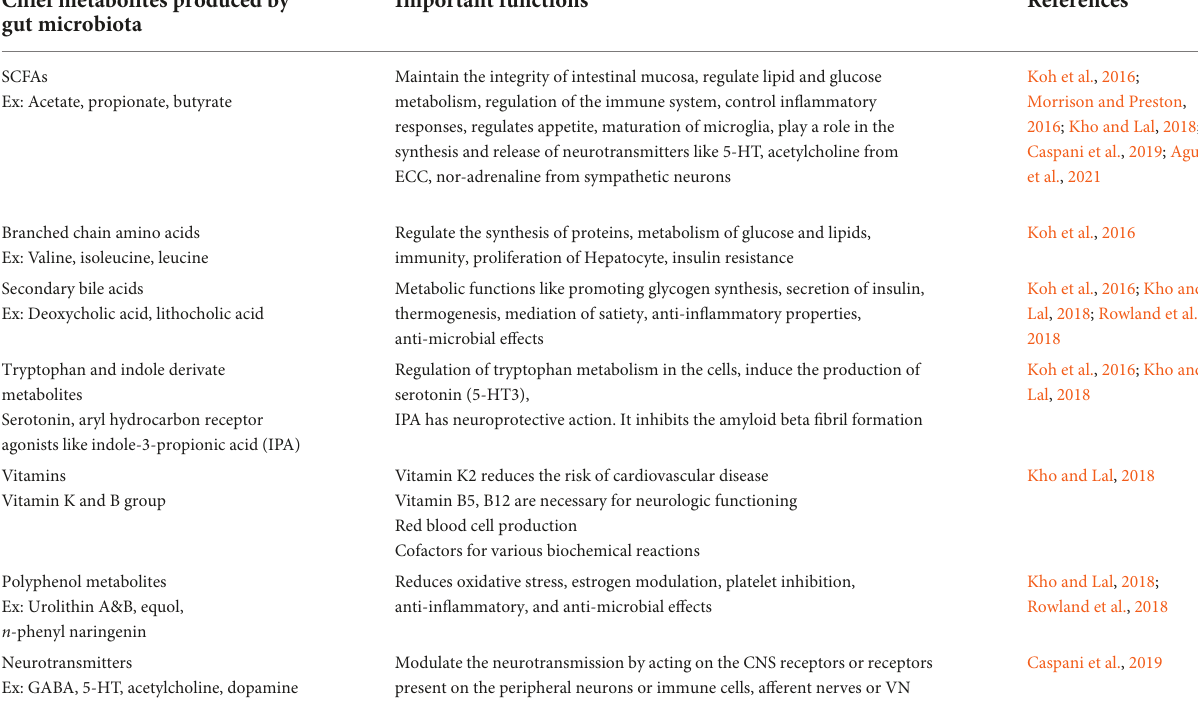
TABLE 1 Chief metabolites produced by the gut